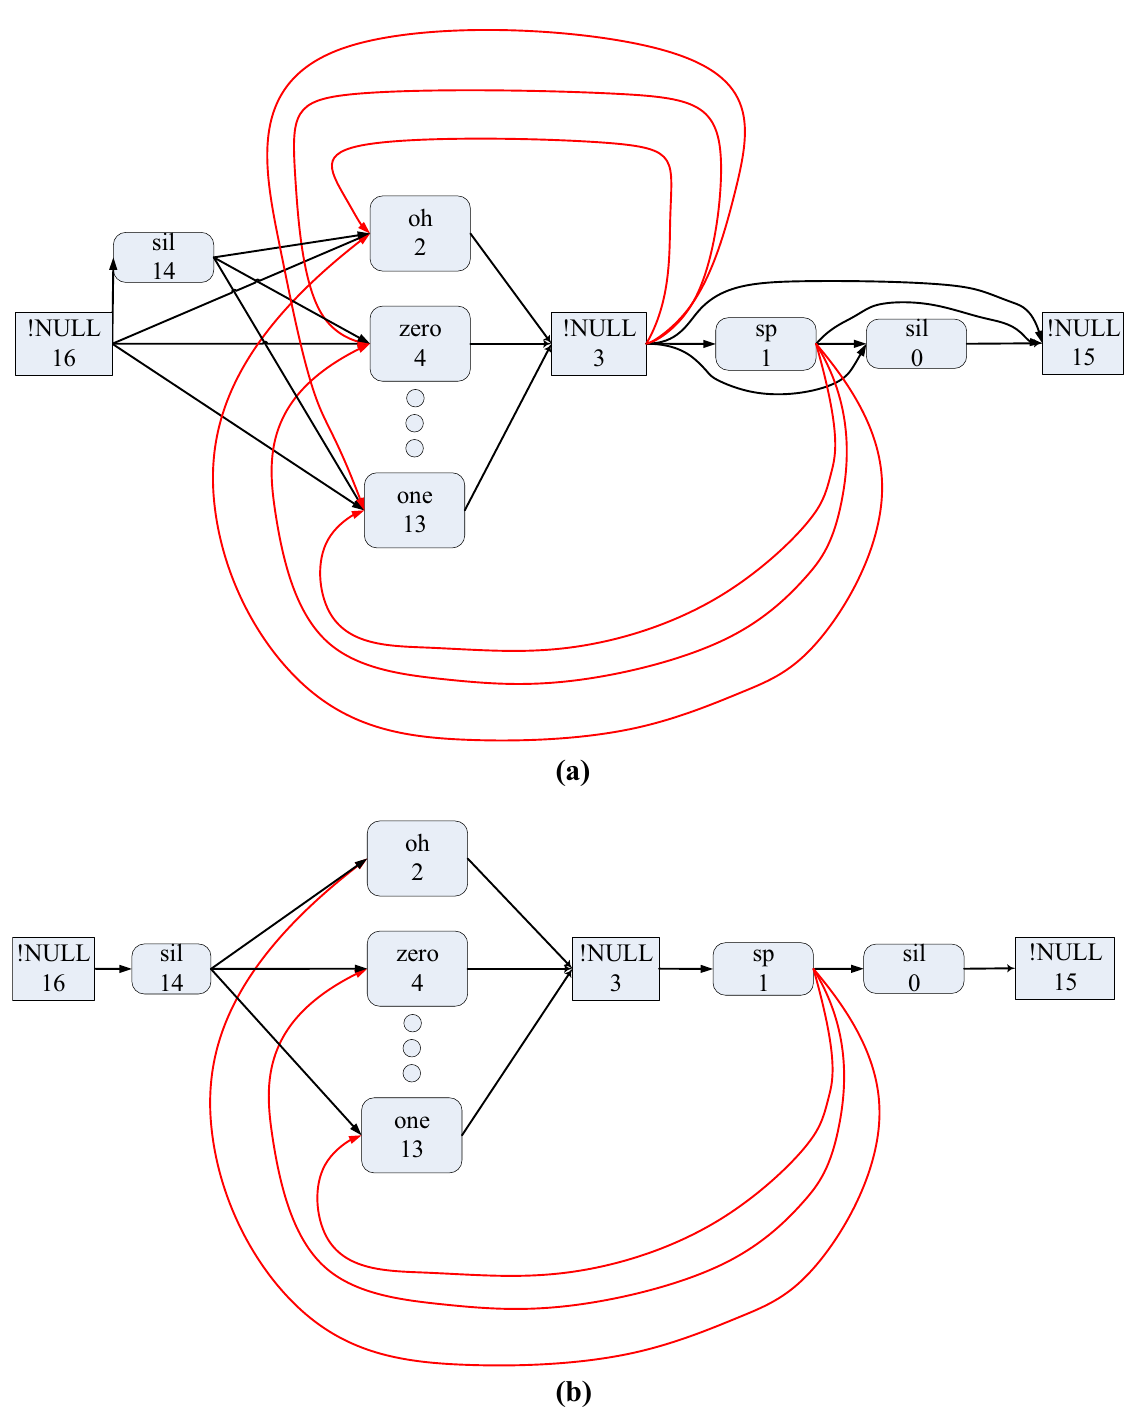
Fig 11. Original and simplified word loop networks. (a) Original Aurora2 word loop network. (b) Our simplified word loop network.